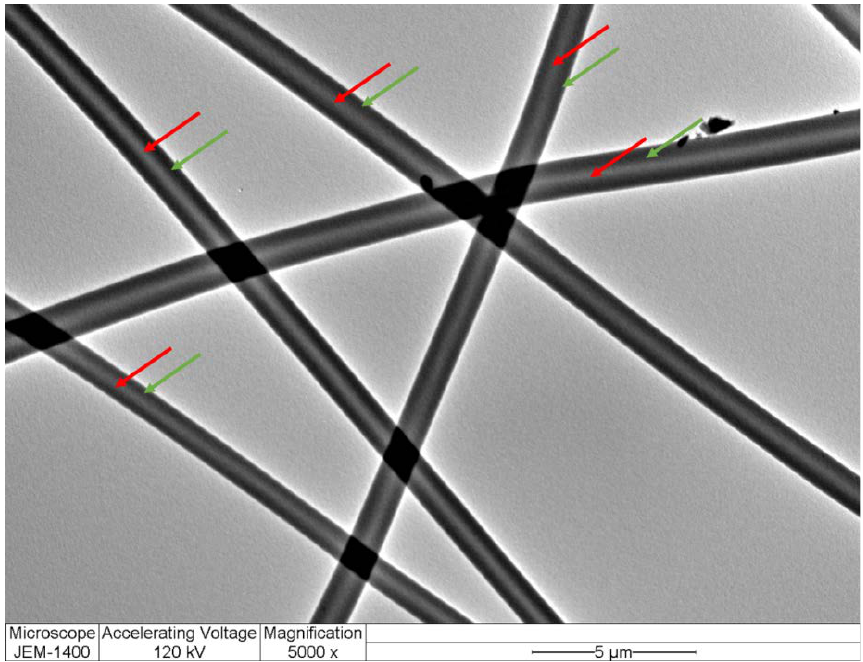
Figure 2. TEM image of drug-loaded core–shell nanofibers showing two distinct layers. The red and green arrows represent the inner and outer layers of the nanofibers, respectively.